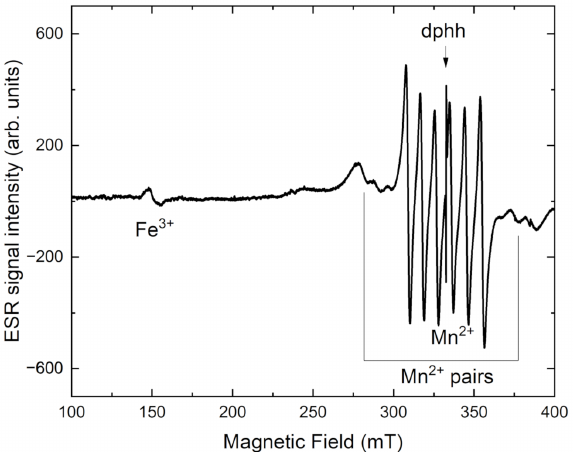
Figure 10. ESR spectrum of tinaksite.